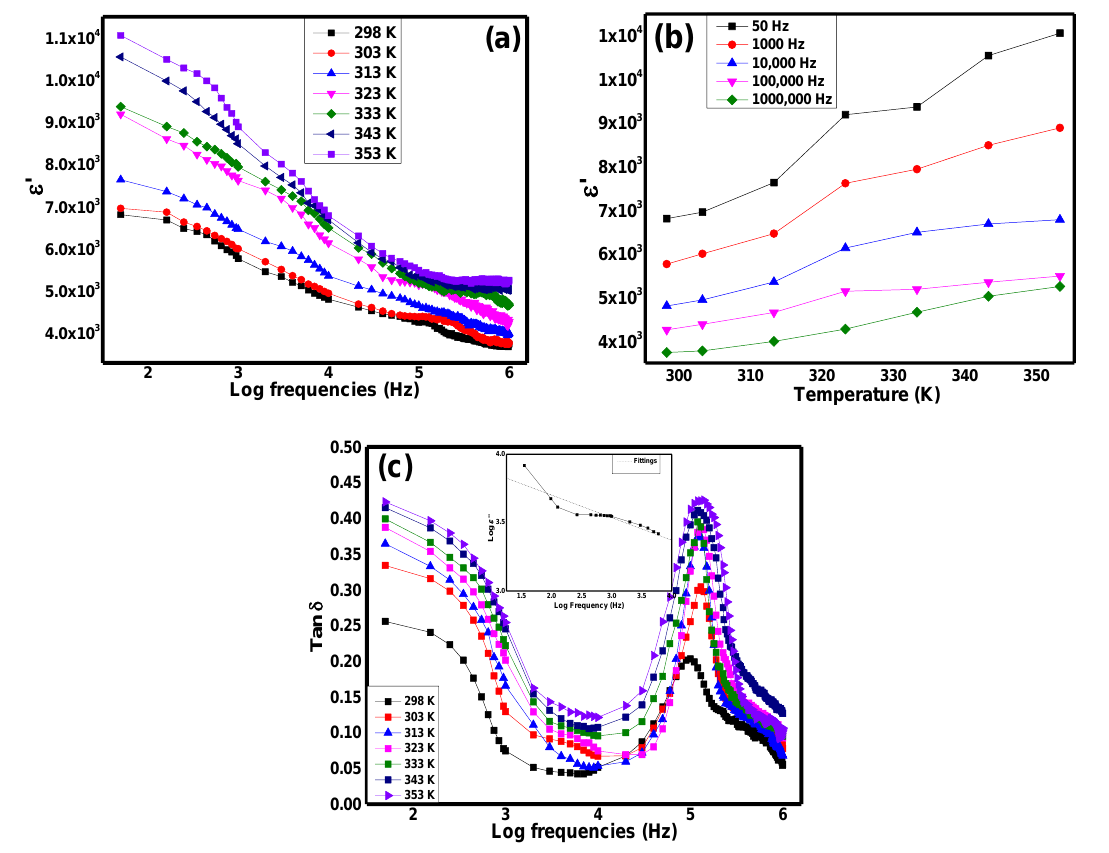
Figure 6. Variation in 𝜺 ’ with ( a ) frequencies, ( b ) temperature, and ( c ) variation in Tan δ with frequencies of Sr 2 CaTeO 6 .